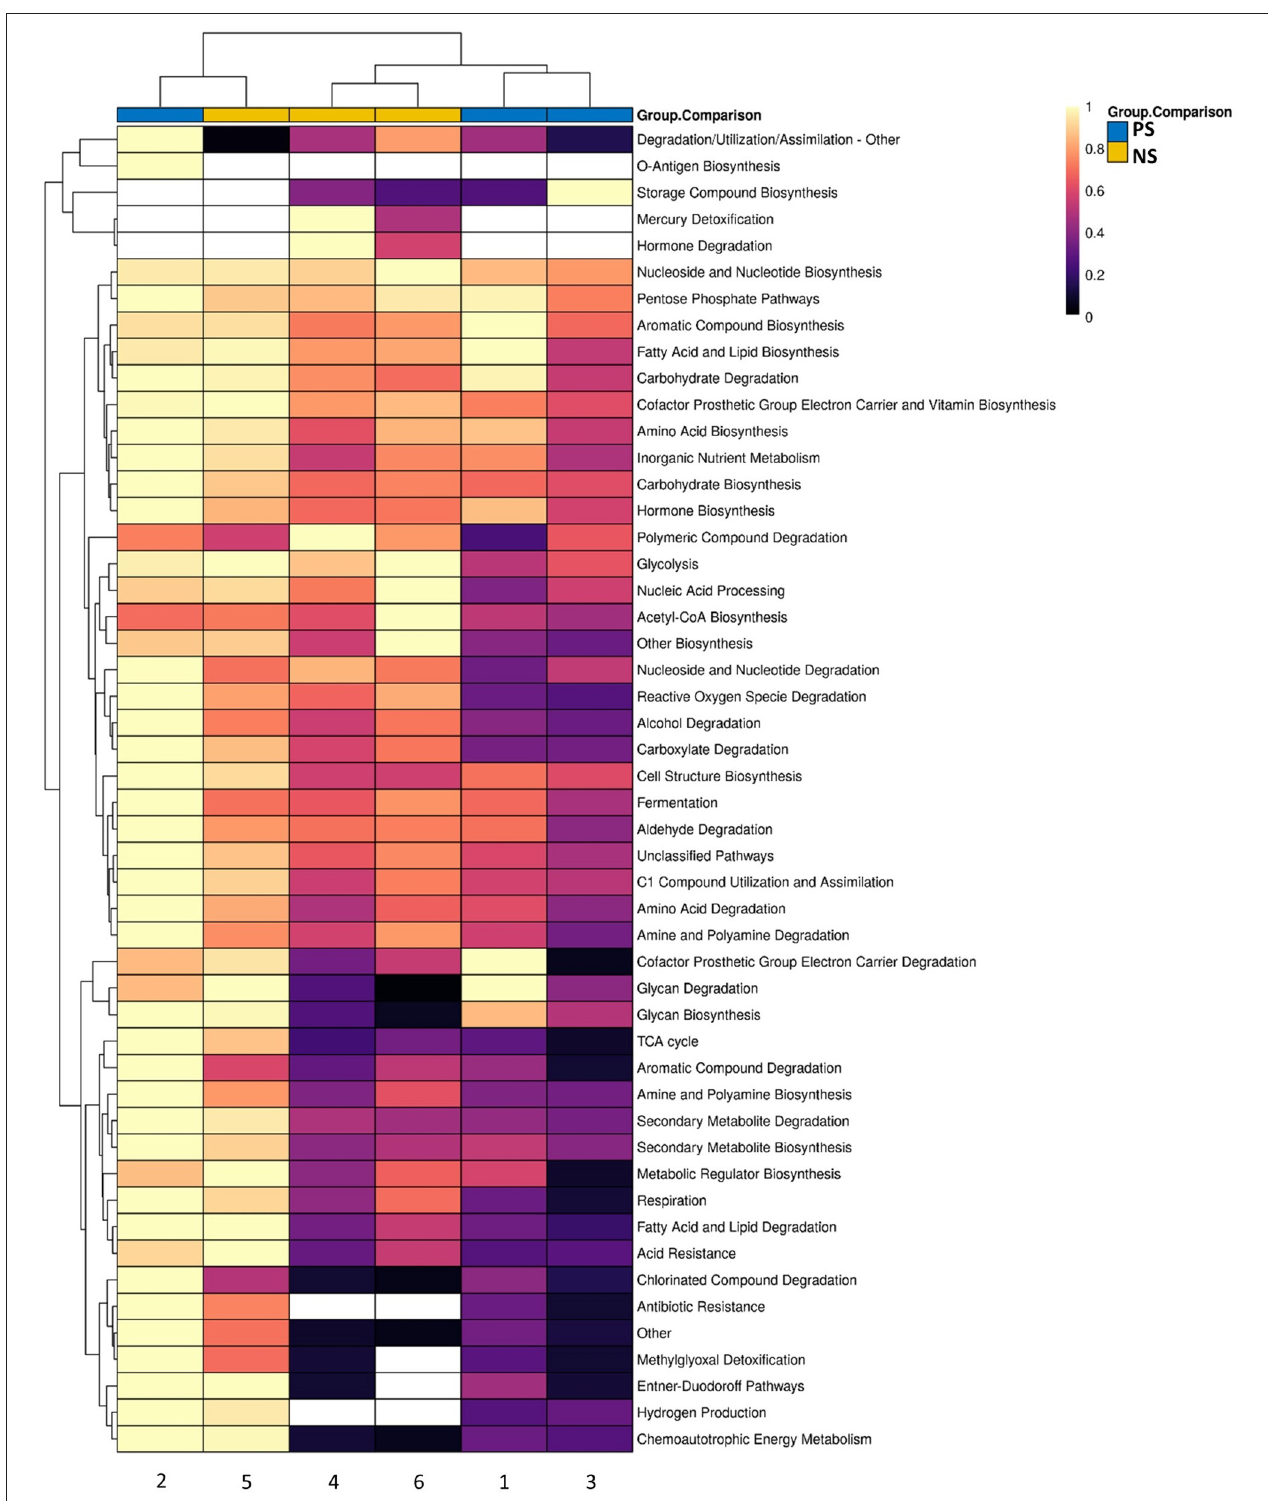
FIGURE 4 | Scaled heatmap of MetaCyc groups for the subset of samples that underwent shotgun metagenomics across probiotic-supplemented ( n = 3) and non-supplemented ( n = 3). Color scale shows not-detected (white), and abundances ranging from low (black) to high (yellow).